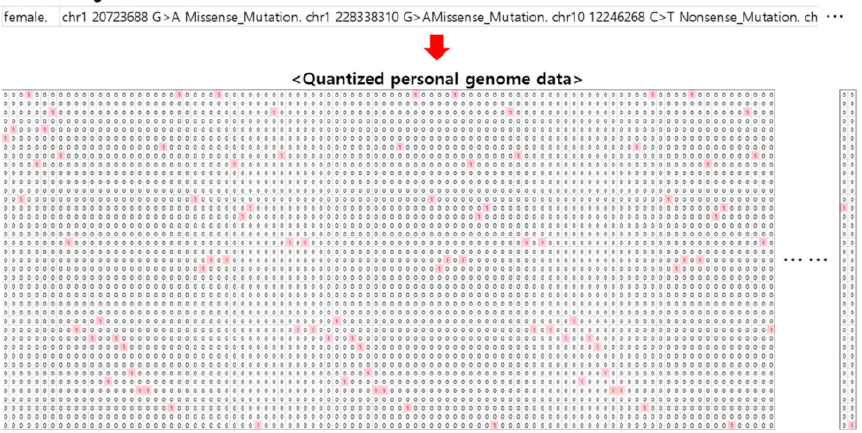
Figure 11. Construction of learning data after data conversion for personal genome